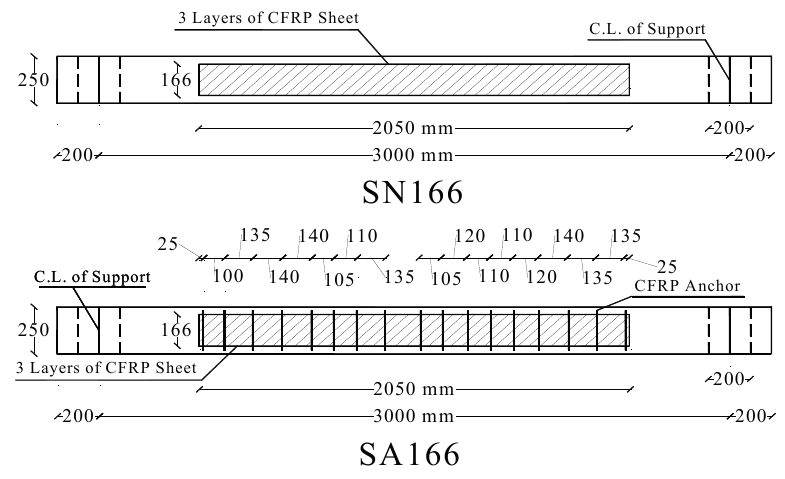
Figure 4. Plan view of tension face of the strengthened beams and their anchor